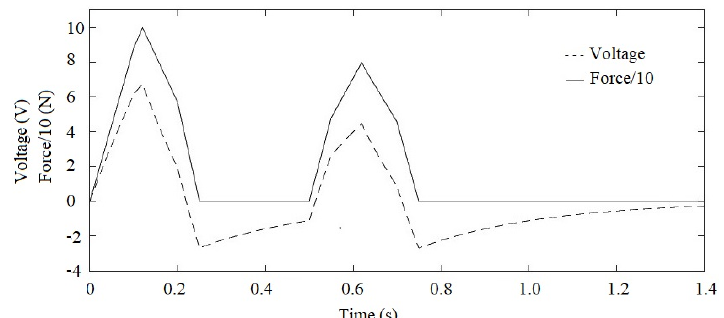
Figure 24. Variation of vertical force and generated voltage by real size TENG.